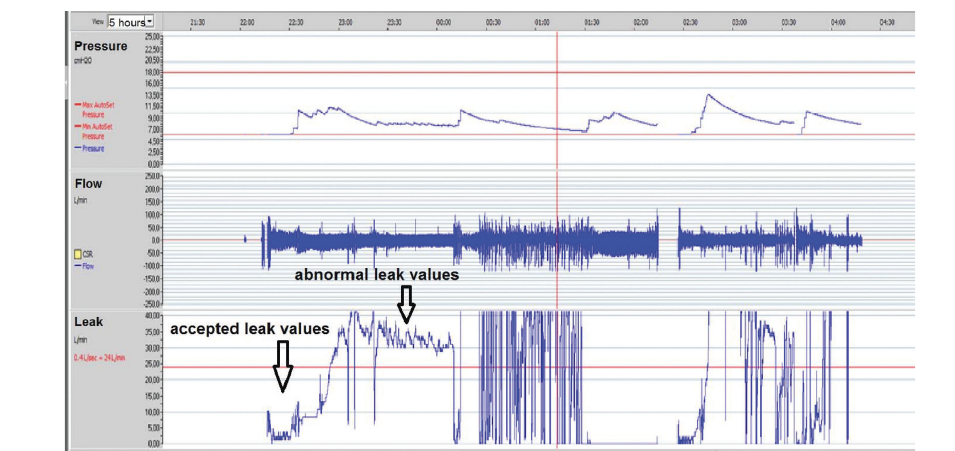
Figure 10: Screenshot of a 5-hour CPAP therapy showing that leak values were acceptable (below 5 liters/minutes) at the beginning of the night and later leak values increased above the critical threshold (24liters/minutes).